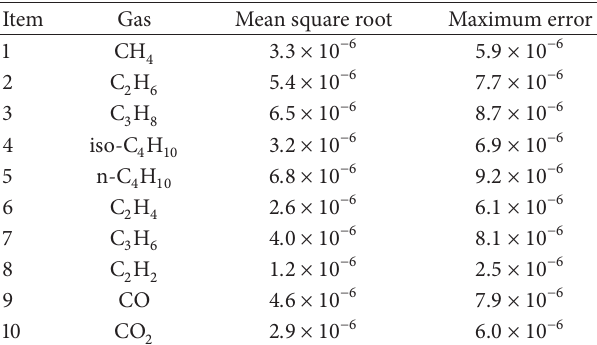
Table 2: Mean square root of the analyte and maximum analysis error in case of background